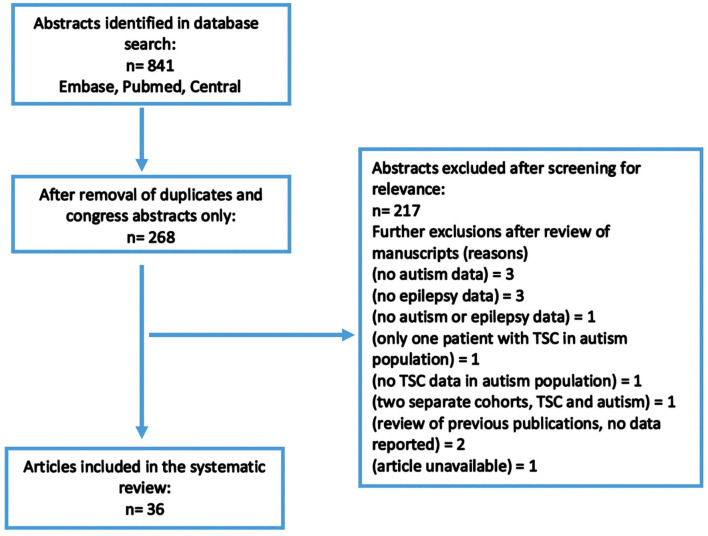
Search strategy.